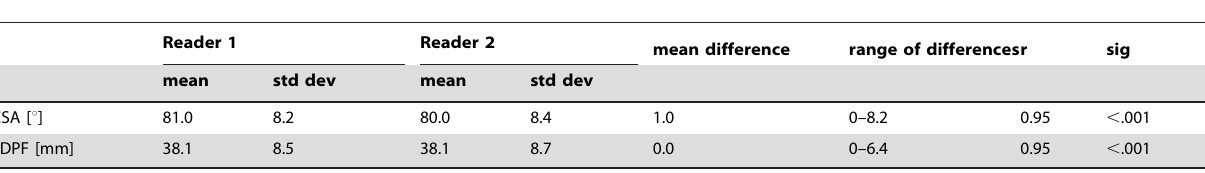
Table 2. Comparison between the two readers regarding CSA and TDPF.